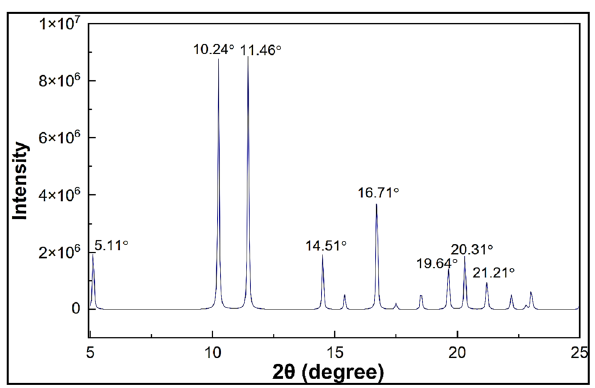
Figure 3: XRD spectra of nylon 66